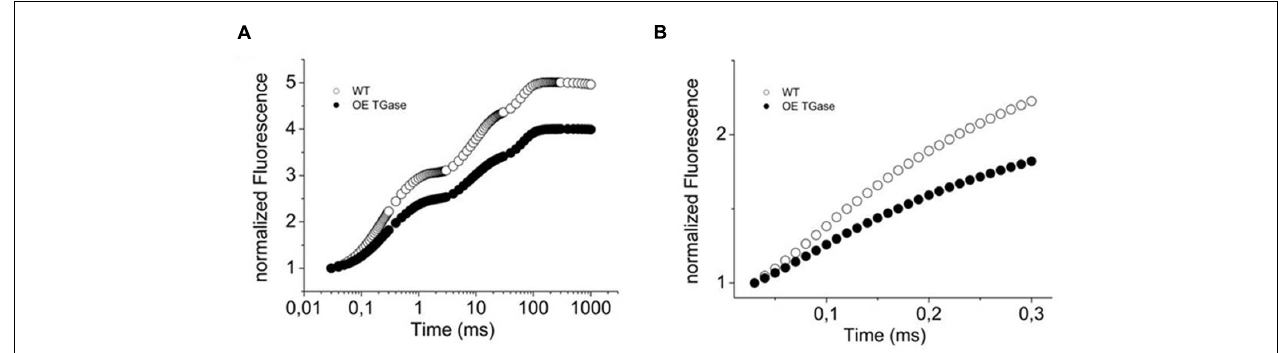
FIGURE 2 | Variable fluorescence (OJIP curve) of WT Arabidopsis (col) and over expressors of plastidial transglutaminase (OE TGase). (A) Fluorescence induction curves normalized to Fo values for WT and OE TGase. (B) Variable fluorescence curves in DCMU inhibited leaves. Reaction centers close at a slower rate in OE TGase (i.e., lower values of fluorescence) indicating that the absorption cross section of PSII is smaller. For a quantitative estimation of antenna size see also Table 1 .